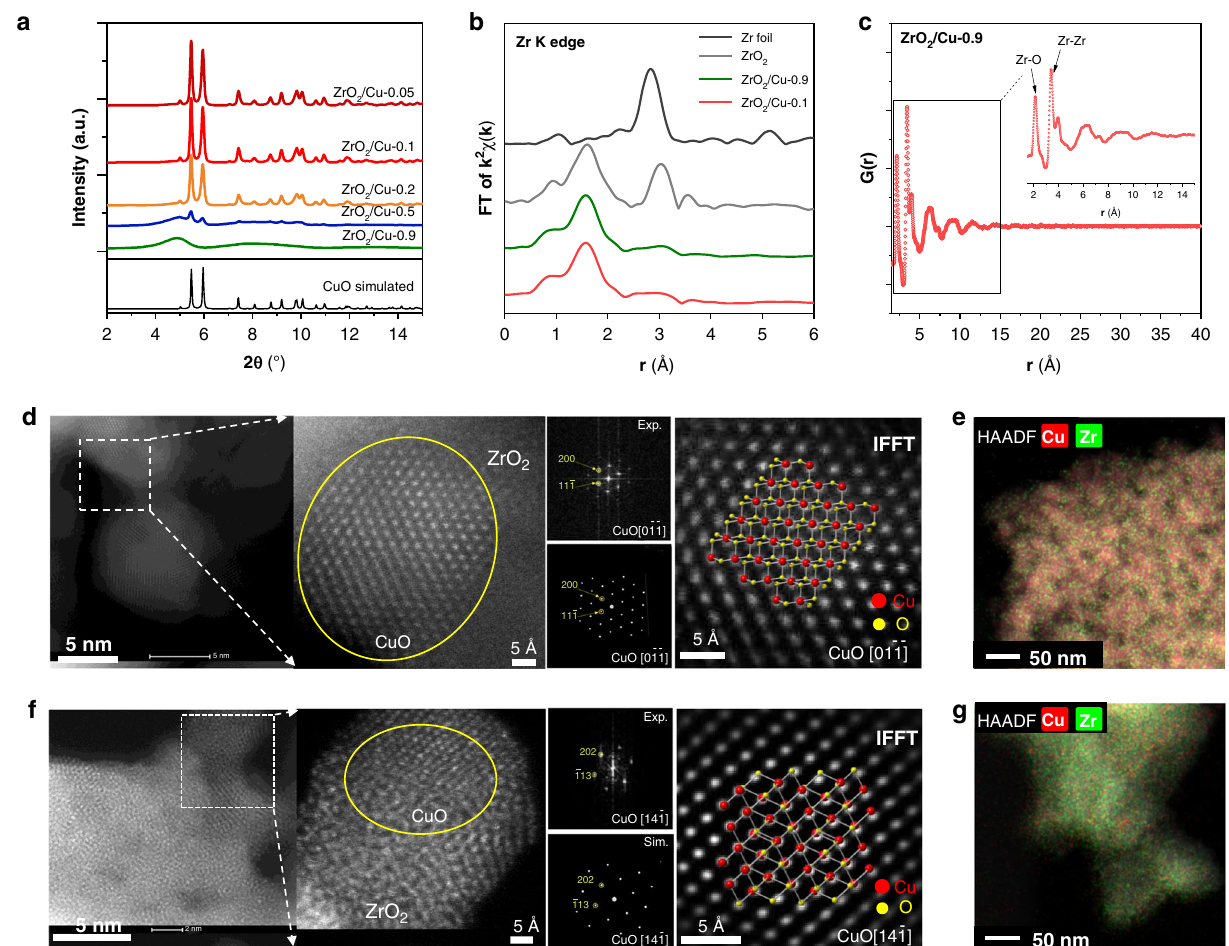
Fig. 1 Structure characterization of the ZrO 2 /Cu-x catalysts. a XRD patterns of the calcined ZrO 2 /Cu-0.05 (dark red), ZrO 2 /Cu-0.1 (red), ZrO 2 /Cu-0.2 (orange), ZrO 2 /Cu-0.5 (blue) and ZrO 2 /Cu-0.9 (green) catalysts (wavelength of the incident X-ray, λ = 0.24125Å). b EXAFS pro fi les of Zr K edge of ZrO 2 /Cu-0.1 (red) and ZrO 2 /Cu-0.9 (green) catalysts with Zr foil (black) and ZrO 2 standards (gray) as references. c PDF structural analysis of the calcined ZrO 2 /Cu-0.9 catalyst. High-resolution HAADF-STEM images/FFT patterns with simulated results and the EDS elemental mapping of the ZrO 2 / Cu-0.1 d , e and ZrO 2 /Cu-0.9 f , g catalysts, respectively. The atomic structures of CuO [0 (cid:1) 1 (cid:1) 1] and [14 (cid:1) 1] are superimposed on the inversed FFT (IFFT) images. The scale bar in the e and g are 50 nm. In elementary mapping images, Zr and Cu are in green and red,